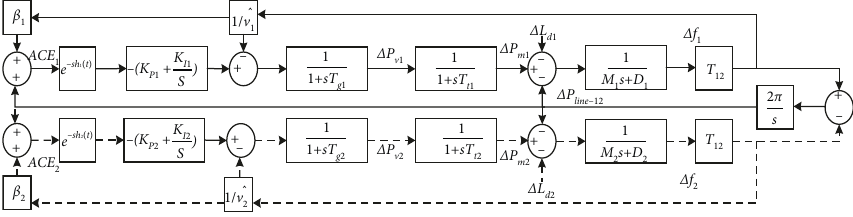
Figure 1: Dynamic model of two-areas LFC scheme and single-area without dotted